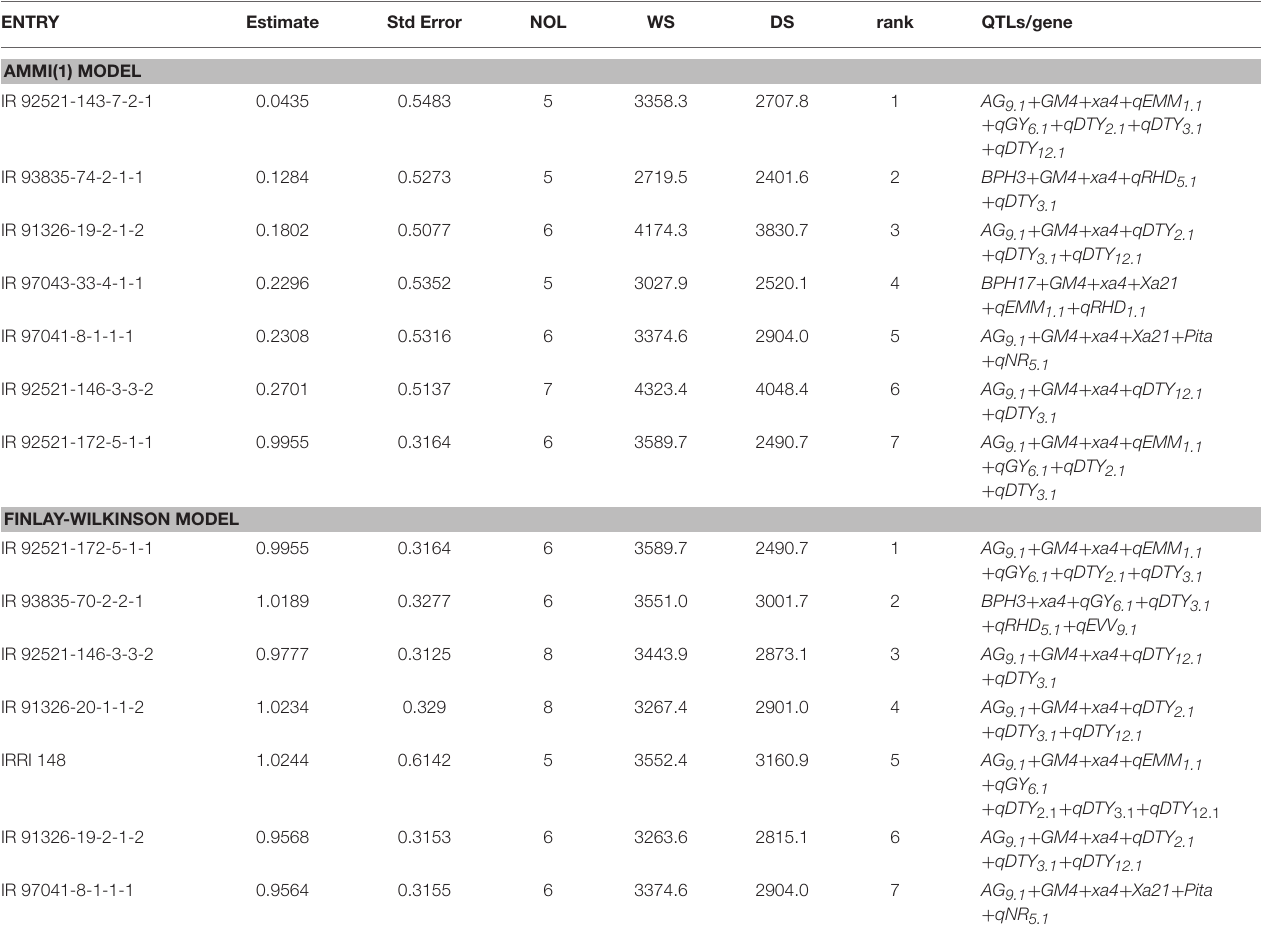
TABLE 6 | Promising lines, their stability ranking based on the best fitting models and the mean yield (kg ha − 1 ) of stable genotypes and QTLs present in promising genotypes increasing rice adaptation under aerobic situation and resistance/tolerance to biotic